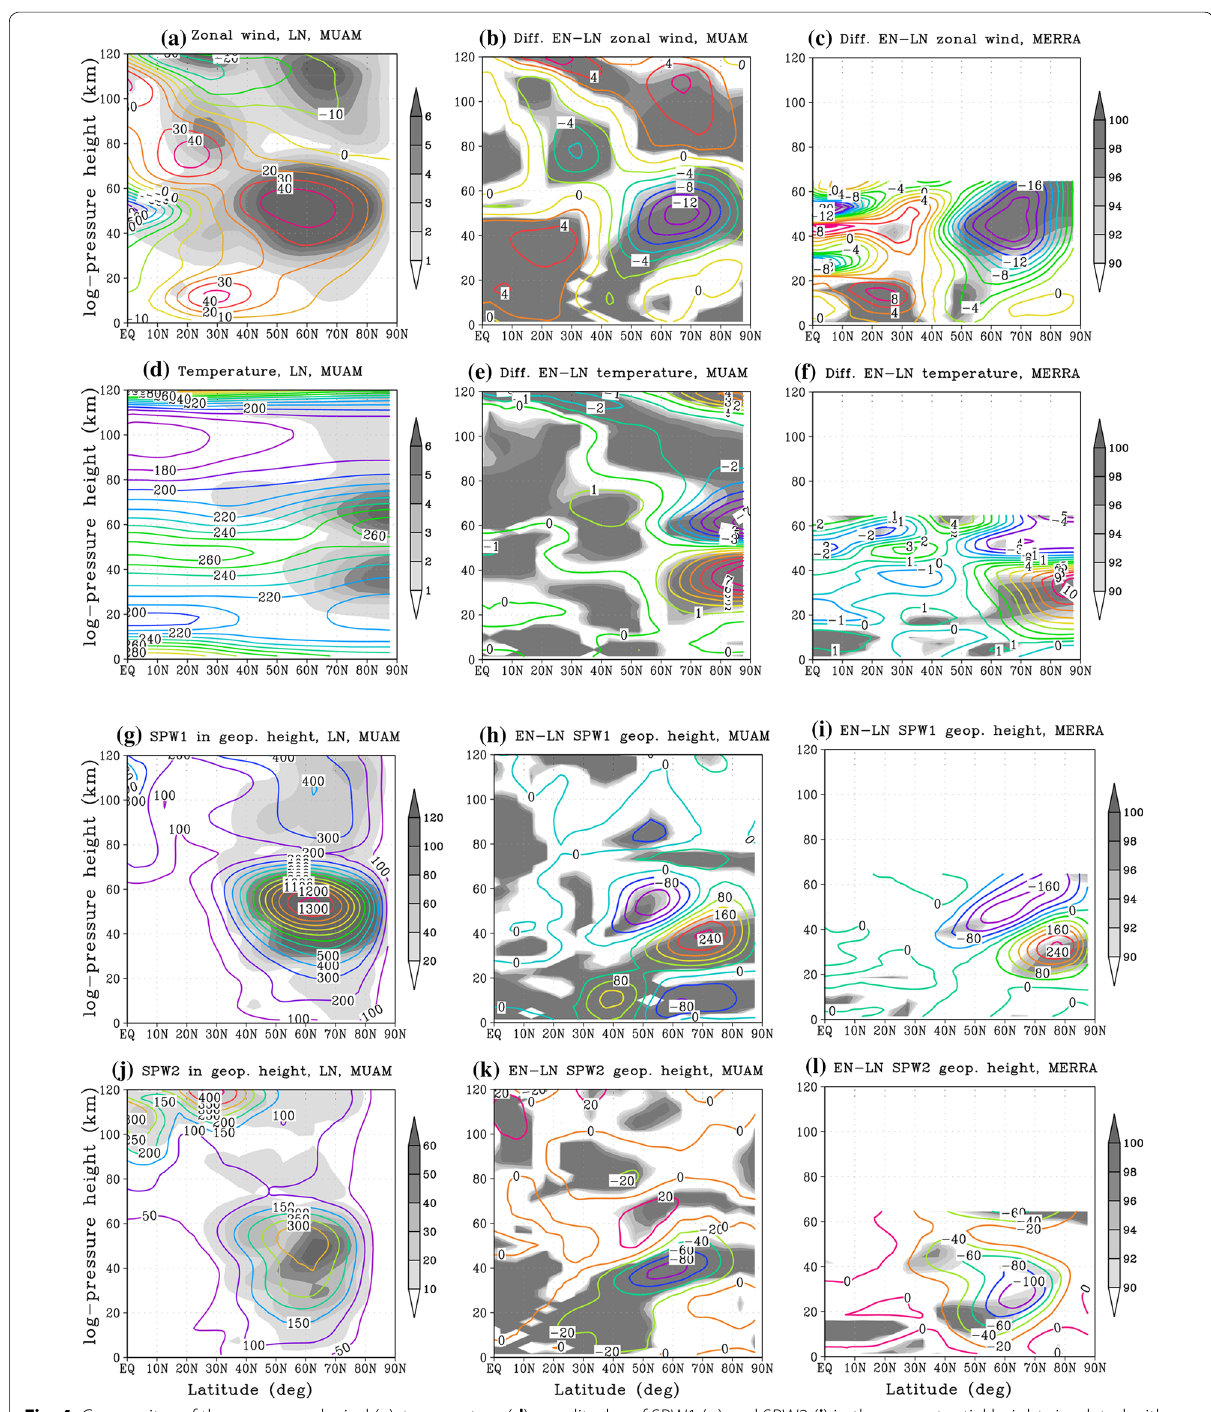
Fig. 4 Composites of the mean zonal wind ( a ), temperature ( d ), amplitudes of SPW1 ( g ) and SPW2 ( j ) in the geopotential height simulated with the MUAM under La Niña conditions (color contours). The corresponding differences ( b , e , h , k ) between ensembles with El Niño and La Niña (color contours). The right panels show the same differences but calculated using the MERRA data ( c , f , l , l ). The shaded areas in the left panels indicate the standard deviations obtained during the ensemble averaging. The shaded regions in the middle and right panels denote the statistical